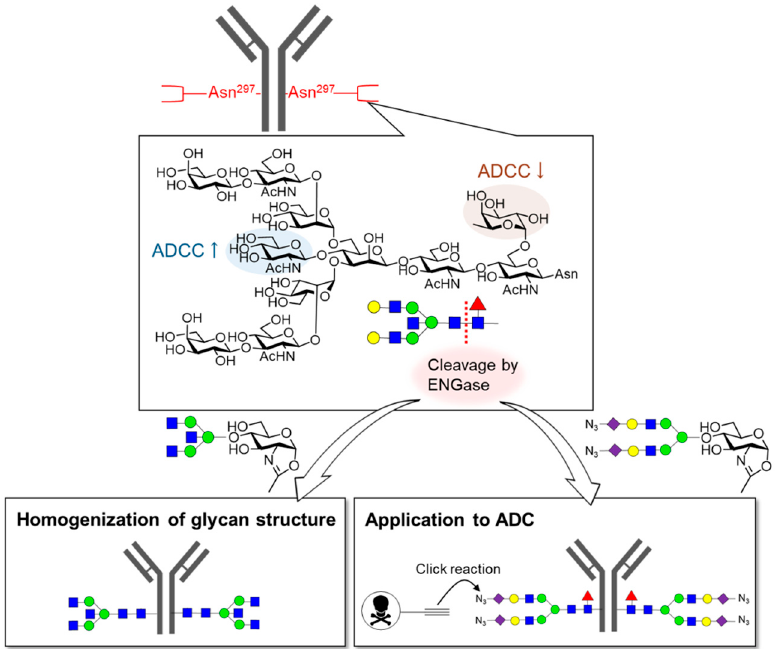
Figure 8. Glycan editing of immunoglobulin (IgG) antibodies. N -Glycans at Asn297 of IgG affect their activity. Core fucose reduces the antibody-dependent cellular cytotoxicity (ADCC) activity, whereas bisecting GlcNAc enhances the ADCC activity. N -Glycan editing using Endo- β - N -acetylglucosaminidase (ENGase) can give IgG as a homogeneous glycoform or can be applied for the preparation of Antibody–drug conjugates (ADCs).